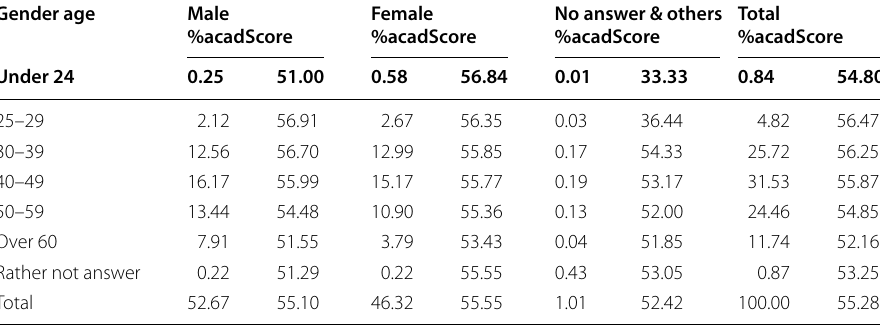
Female %acadScore